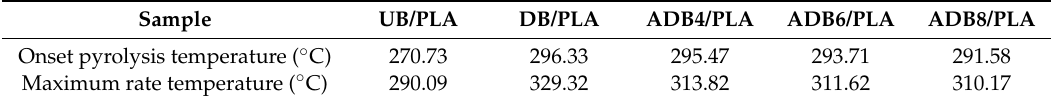
Table 3. Thermal parameters of BF/PLA composites with various treatments.